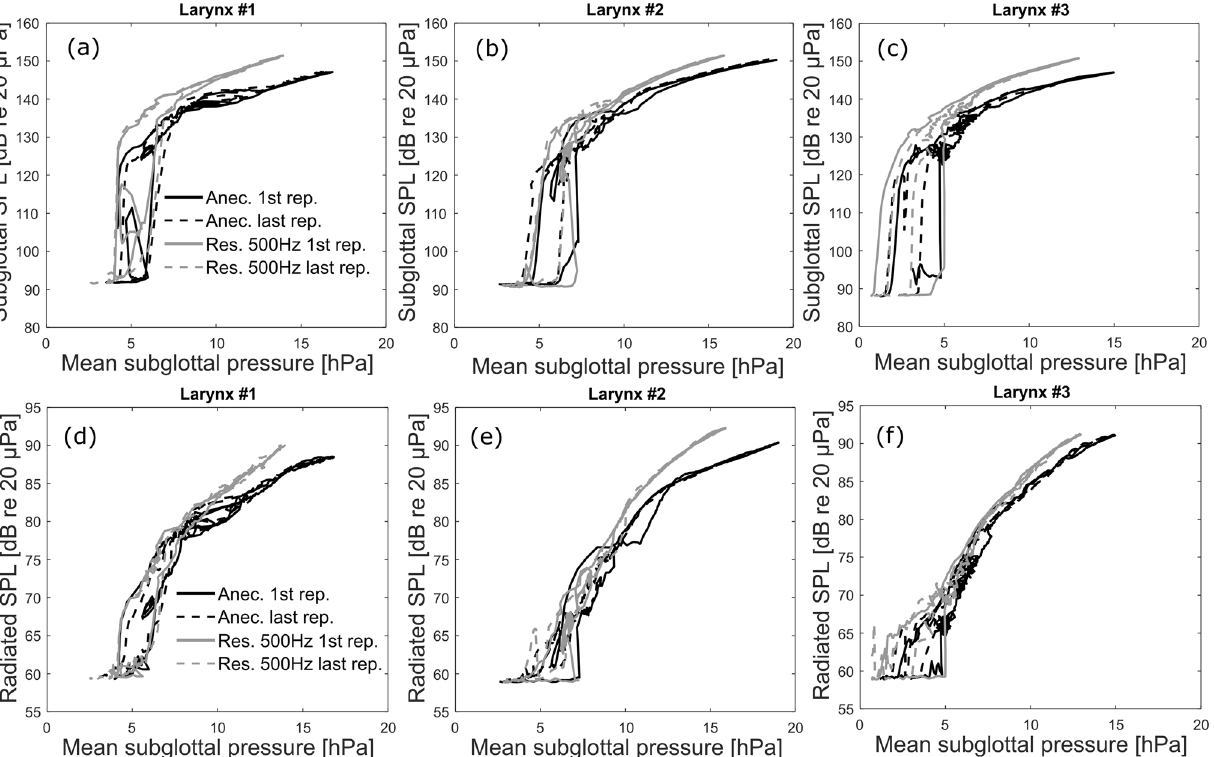
Figure 7. Analysis of the SPL (non-weighted) of the subglottal ( a – c ) and radiated ( d – f ) sounds at 10 cm distance with regards to the mean subglottal pressure. The black lines mark the data measured with the anechoic tract, whereas the gray lines mark the data measured with the resonant subglottal tract set to f R1 = 500 Hz. ( a , d ) First larynx, ( b , e ) second larynx, ( c , f ): third larynx. Notice that for a given subglottal pressure the SPLs are higher in the resonant than in the anechoic tract. For clarity, only the results from the first and last flow sweeps are shown, for each larynx. The solid lines correspond to the first flow sweep and the dashed lines to the last flow sweep for each larynx, illustrating the repeatability of the